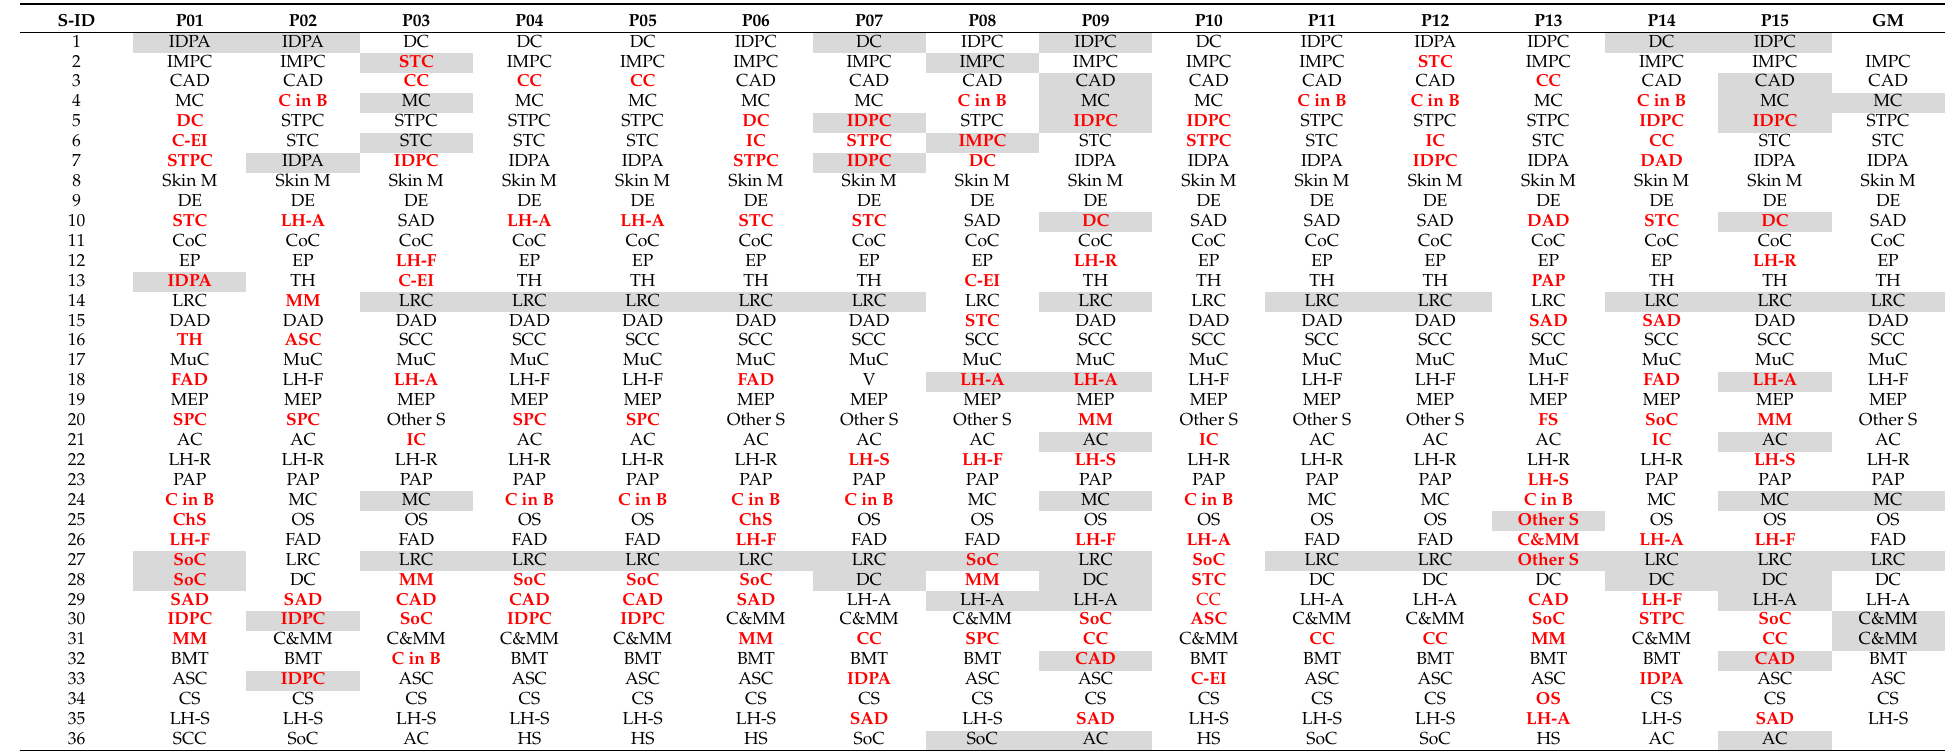
Table 5. Classification of histological subtypes by the 15 panellists (P) for the 36 canine mammary tumour samples included in the study. In bold red the diagnoses that differed from the majority opinion (GM), in grey boxes diagnoses repeated by the same